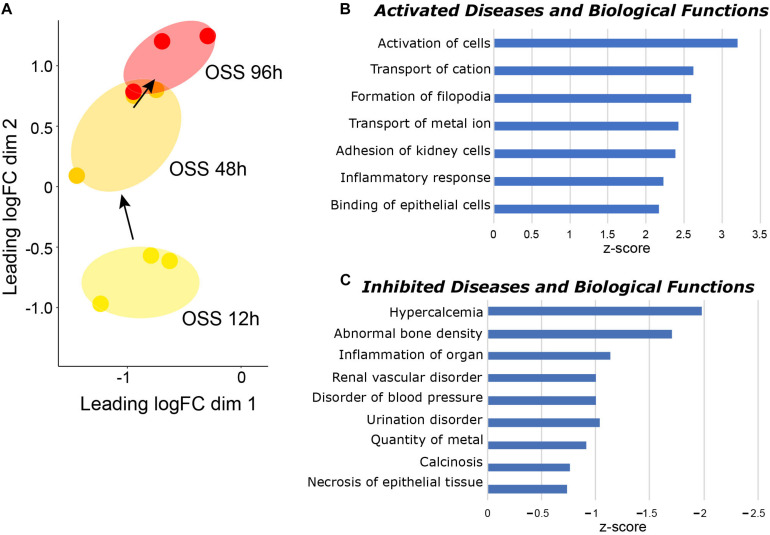
Temporal gene expression changes in cells exposed to OSS. (A) MDS visualization of the gene expression profiles using IPA comparison analysis (96 h OSS vs. 48 h OSS and 48 h OSS vs. 12 h OSS). IPA Diseases and Biological Function terms that are selectively (B) enriched and (C) de-enriched at later times (96 h OSS vs. 48 h OSS) compared with early times of OK cell culture under OSS (48 h OSS vs. 12 h OSS) are plotted in order of increasing activation z-score.